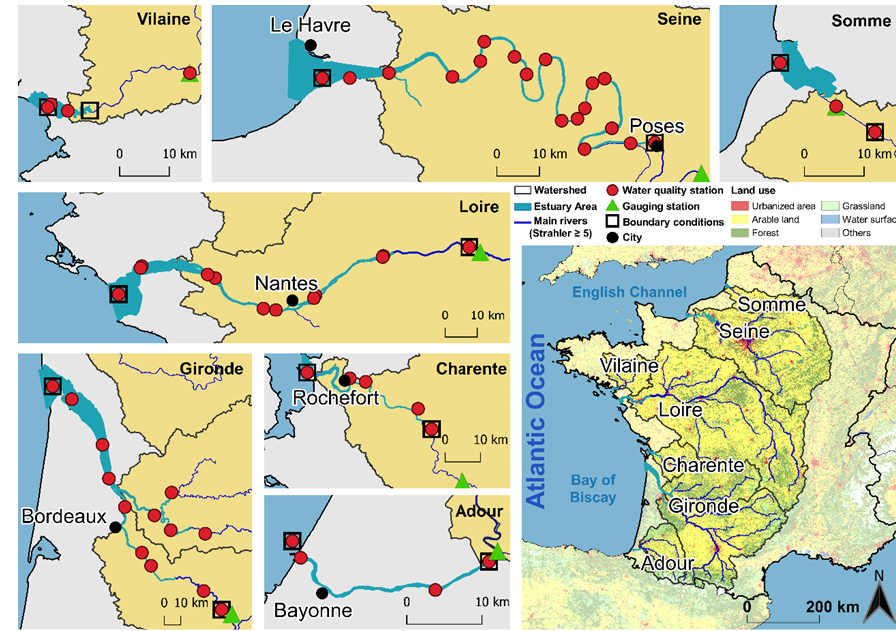
Figure 1. Map of estuaries studied along the French Atlantic coast. Panels for each estuary indicate the locations of the gauging stations and the water quality stations used in this study. Table 1. Geometric properties of the estuaries